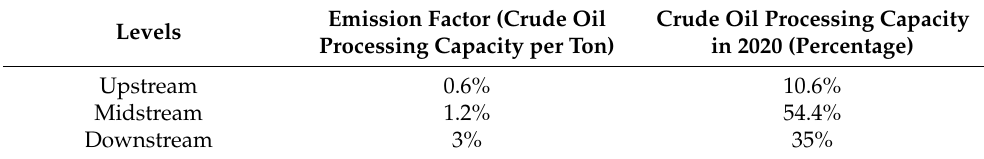
Table 4. The emission factors and crude oil processing capacity of the PR industry in China.